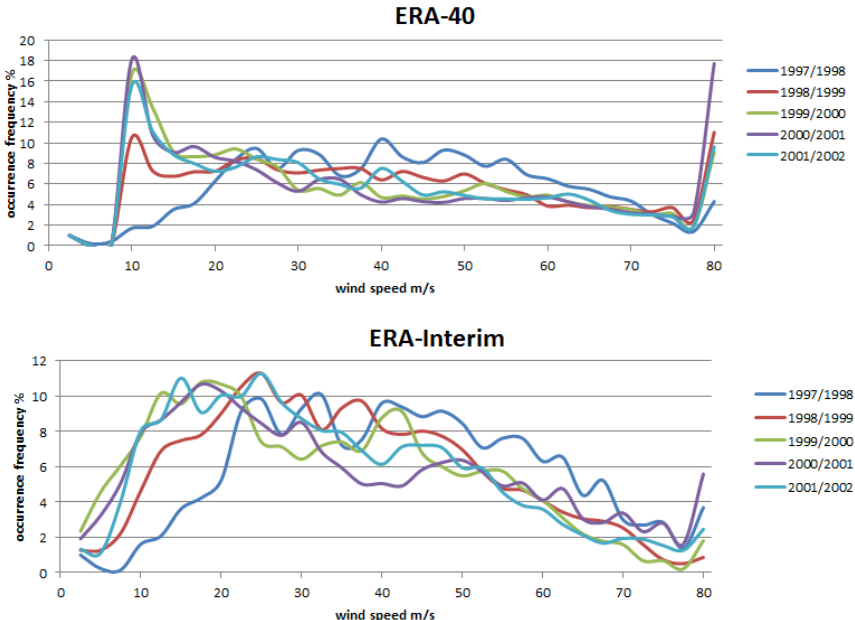
Fig. 9. Wind speed of ERA-40 (top) and ERA-Interim (bottom) for 52.5 ◦ N, sector 0–90 ◦ E, 10hPa, for the winters of 1997/1998 to 2001/2002. High values at 80ms − 1 are the sum of all speeds ≥ 80ms − 1